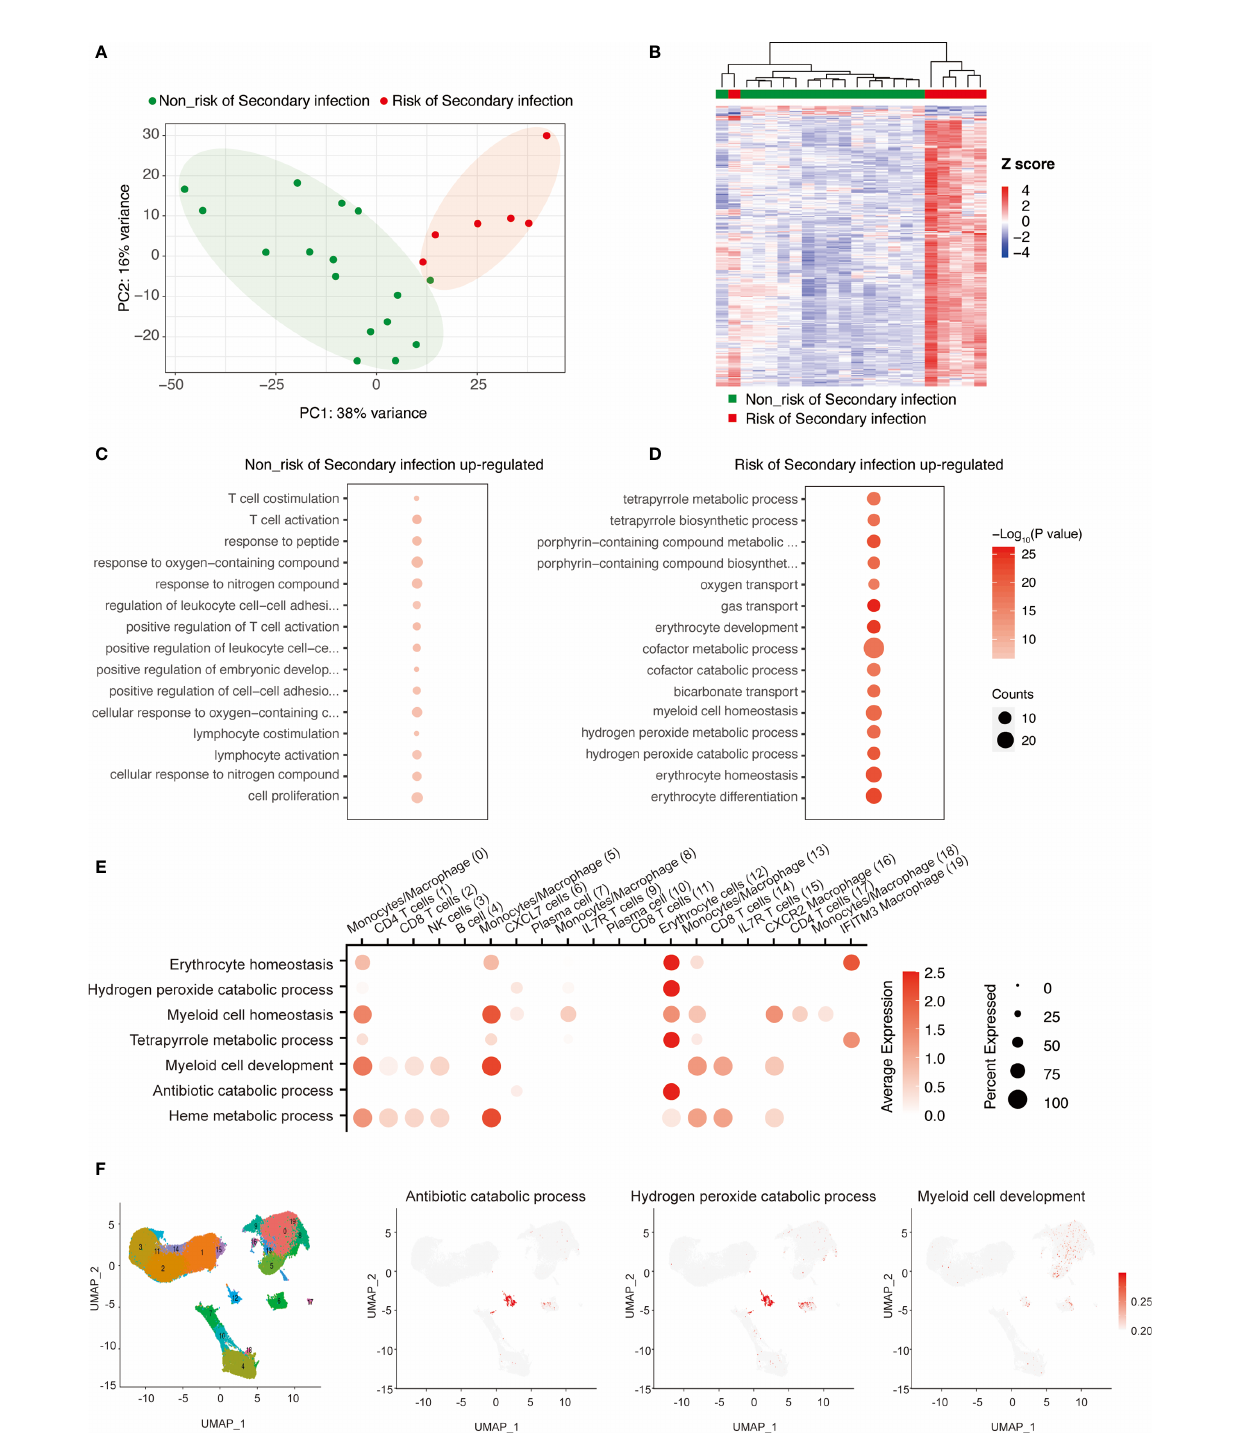
FIGURE 2 | Identifying the key transcriptional programs that might enhance the risk of secondary infection at the initial infection of SARS-COV-2. (A) PCA analyses of the severe cases with or without the risk of secondary infection. (B) Heatmap showing the differentially expressed genes in PBMC cells between risk and non-risk of secondary infection. (C, D) Functional annotation of genes correlated with risk of secondary infection during the initial infection. (E, F) scRNA-seq analyses showing the enriched of these risk genes in distinct immune cells from